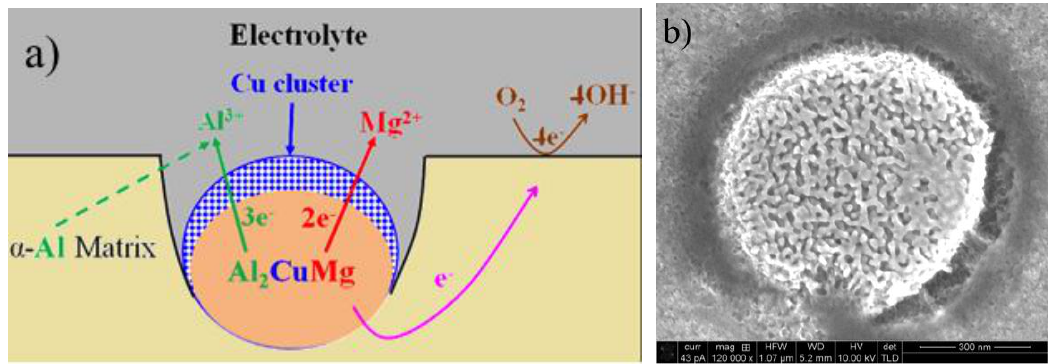
Figure 1. Schematic dealloying and subsequent trenching corrosion process of Al 2 CuMg in AA2024 ( a ); and scanning electron microscope (SEM) images of resulted corrosion morphology after 1-hour exposure in aerated De-ionized water at 30 °C ( b ).